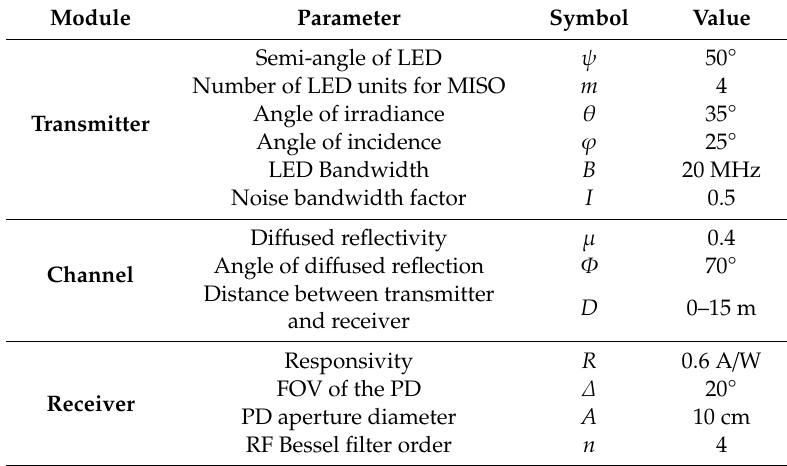
Table 1. Set of parameters used for the analytical model and their values for the simulation analysis. Module Parameter Symbol Value Semi-angle of LED ψ 50 ◦ Number of LED units for MISO Angle of irradiance Transmitter